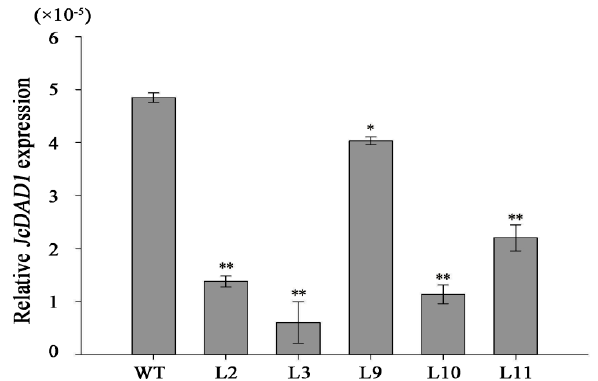
Figure 3. Relative expression levels of JcDAD1 in inflorescence buds of the wild type (WT) plants and JcDAD1 -RNAi transgenic Jatropha lines (L2, L3, L9, L10, and L12). Two biological replicates and three technical replicates were prepared for qRT-PCR assays. JcActin was used as the internal reference. Error bars represent standard errors ( n = 2). Student’s t -test was performed to analyze significant differences. ** Extremely significant difference ( p < 0.01). * Significant difference ( p < 0.05).